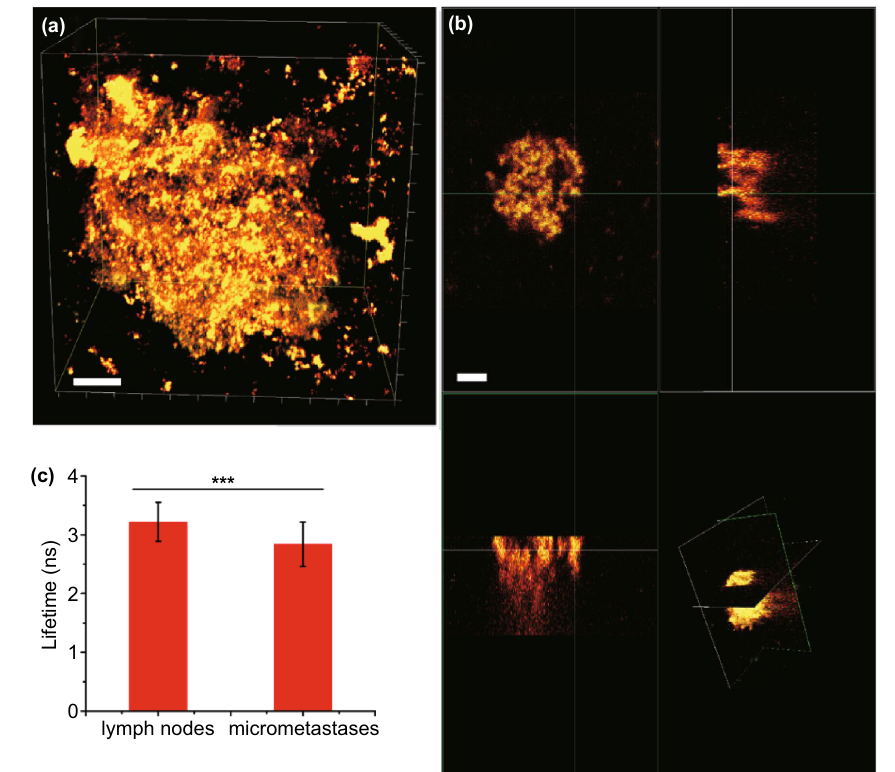
Fig. 6 a In vivo images showing the FLIM images of in H1299 tumor cells in agarose sections of lymph nodes from in vivo mouse models . Scale bar: 200 µm. b 3D FLIM image of a micrometastasis. Scale bar: 100 µm. c Relative lifetime values of mice in lymph nodes and microme- tastasis. 10 independent optical slices were randomly selected. Means of sets of data were statistically evaluated using a two-tailed unpaired t test on GraphPad Prism (confidence interval: 95%). ***P < 0.01 (Welch’s t